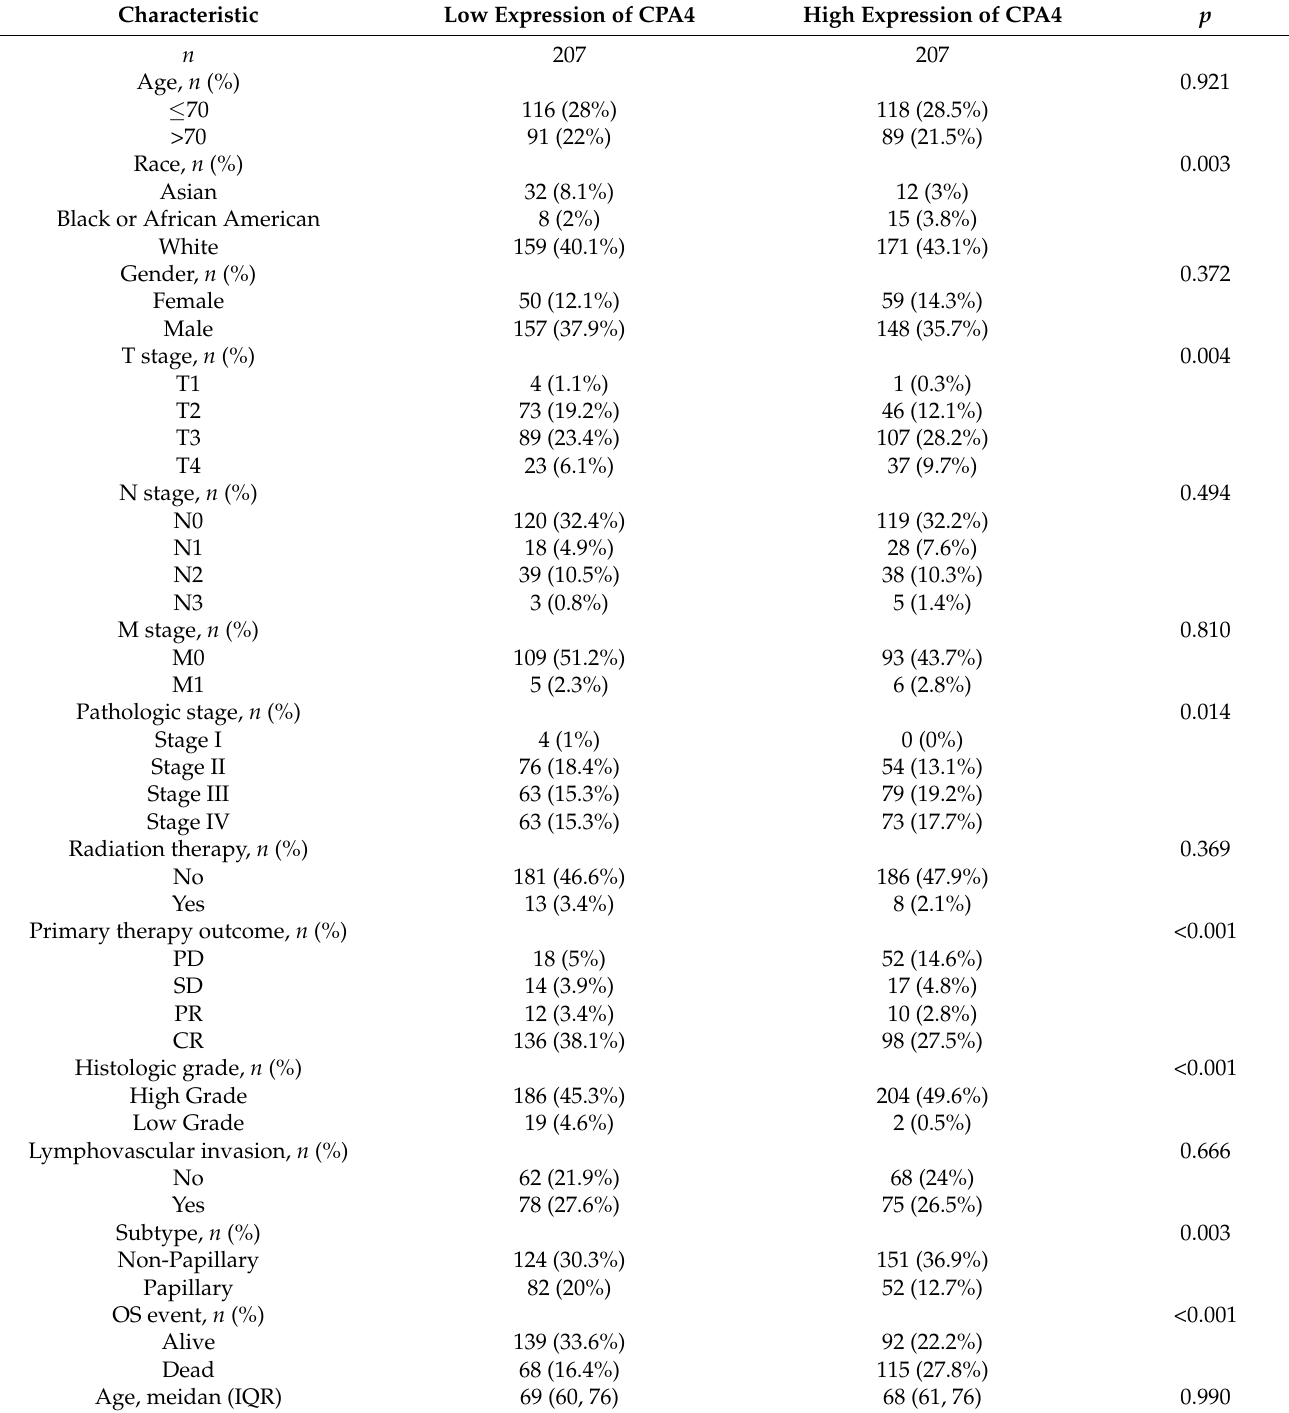
Table 1. Clinical characteristics of two sets of patients with different expressions of CPA4 from the TCGA dataset. Characteristic Low Expression of CPA4 High Expression of